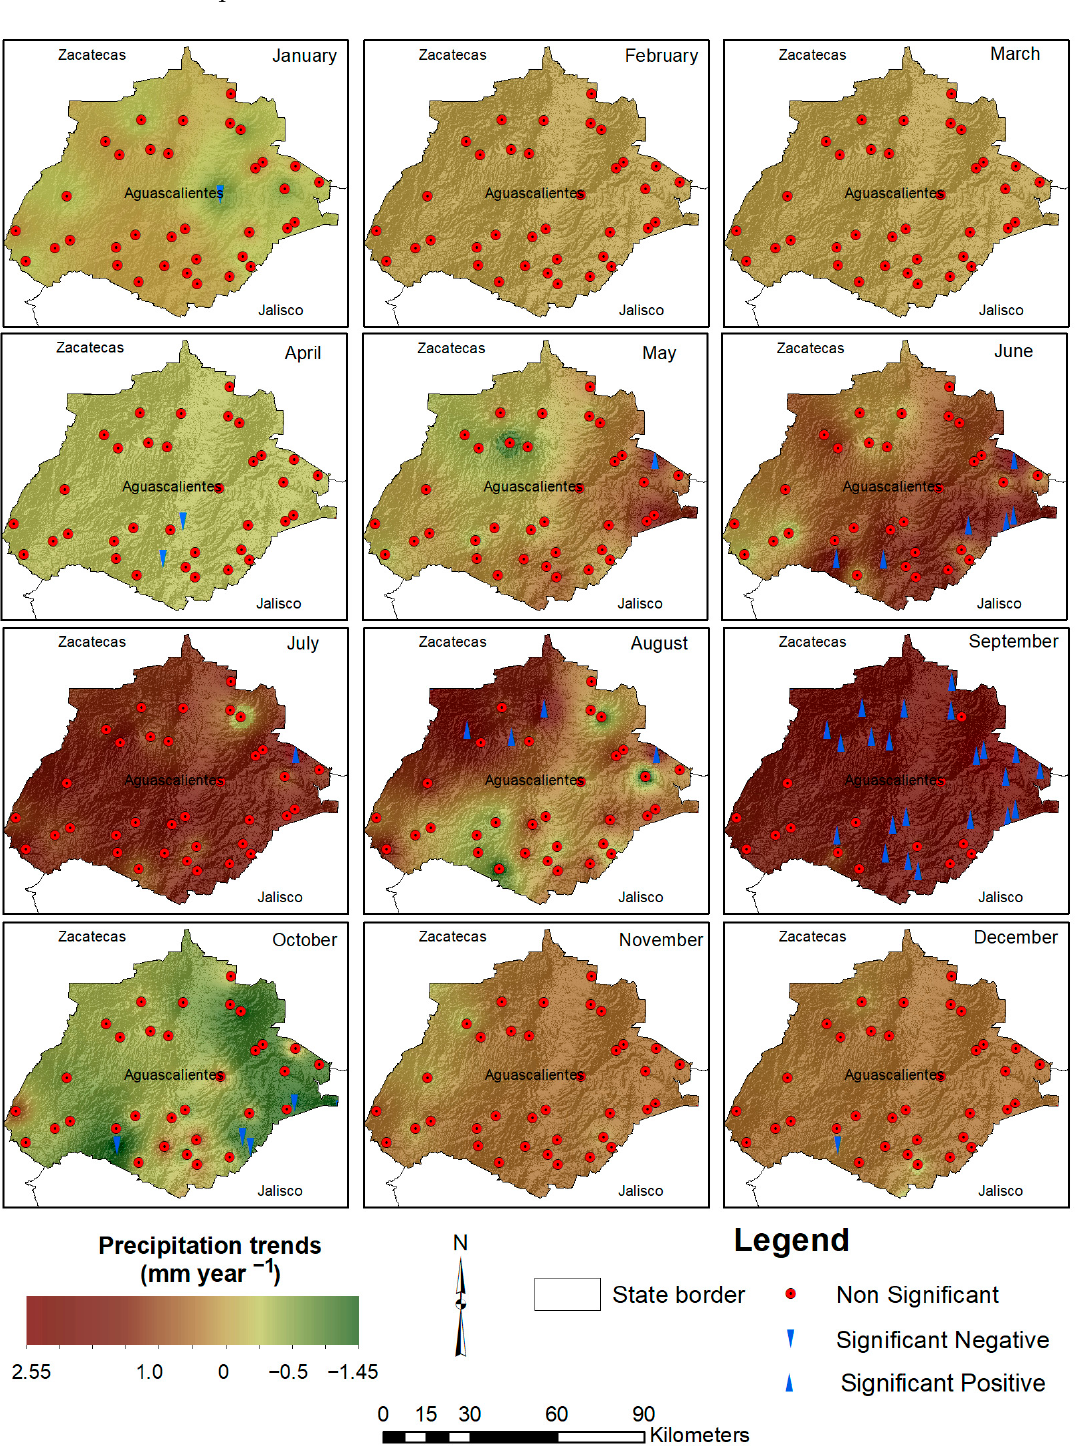
Figure 3. Spatial variation of monthly precipitation trend from January to December in Aguascalientes.